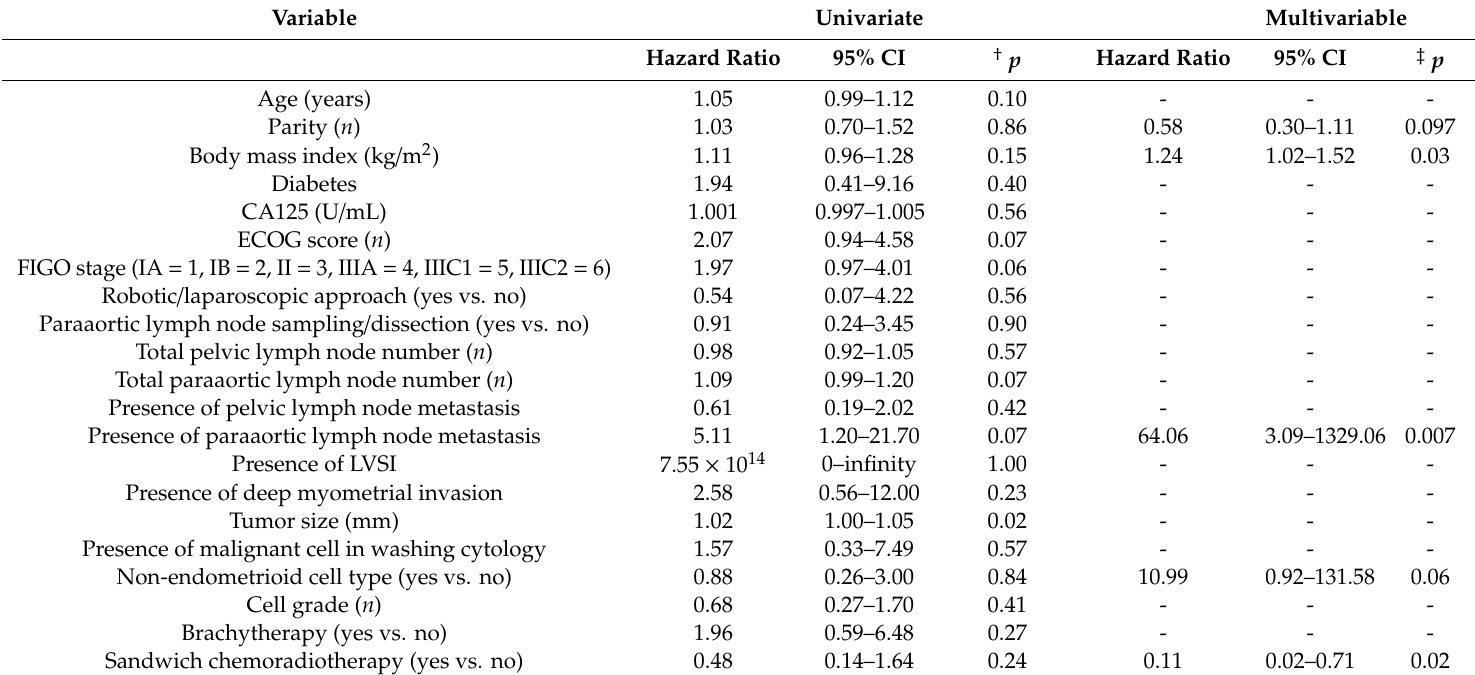
The abbreviations are the same as in Table 1. † Cox proportional-hazards model. ‡ Multivariable backward stepwise Cox proportional-hazards modeling was performed by using all variables in the univariate analysis until all remaining variable(s) with p <